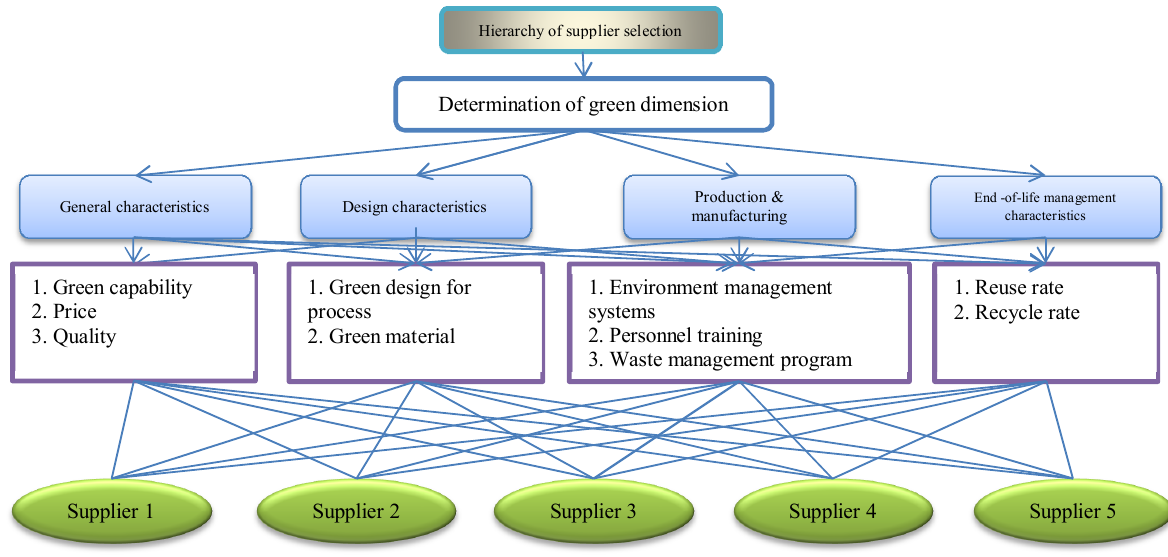
Fig. 4. Hierarchical view of green supplier selection